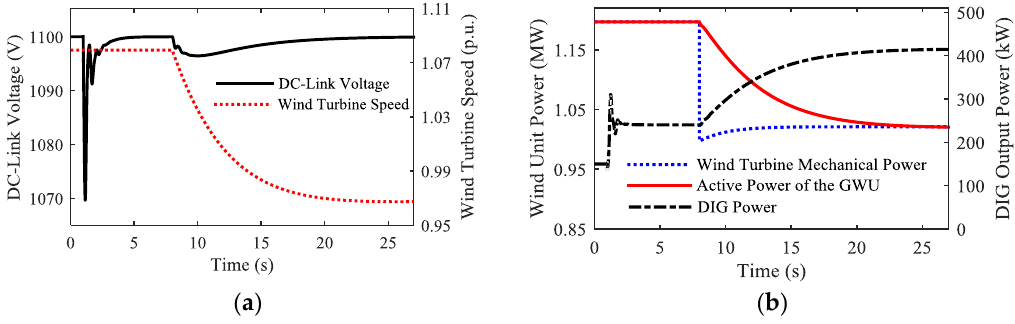
Figure 11. System dynamics for the scenario corresponding to the wind-diesel mode: ( a ) DC-link voltage and wind turbine speed; ( b ) Power in different components of the system.